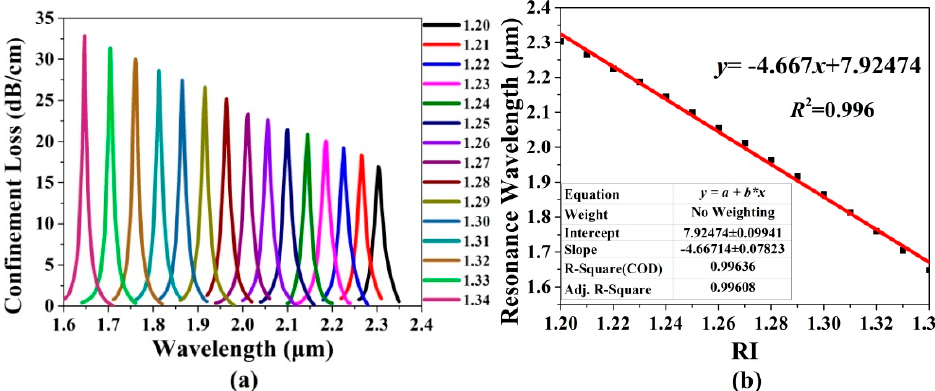
Figure 7. ( a ) The confinement loss spectra of the x -pol core mode of the gold wires-filled HC-NCF when the RI of the filled analyte changes from 1.20 to 1.34, and ( b ) the corresponding variation in the confinement loss peak wavelength and linear fitting.